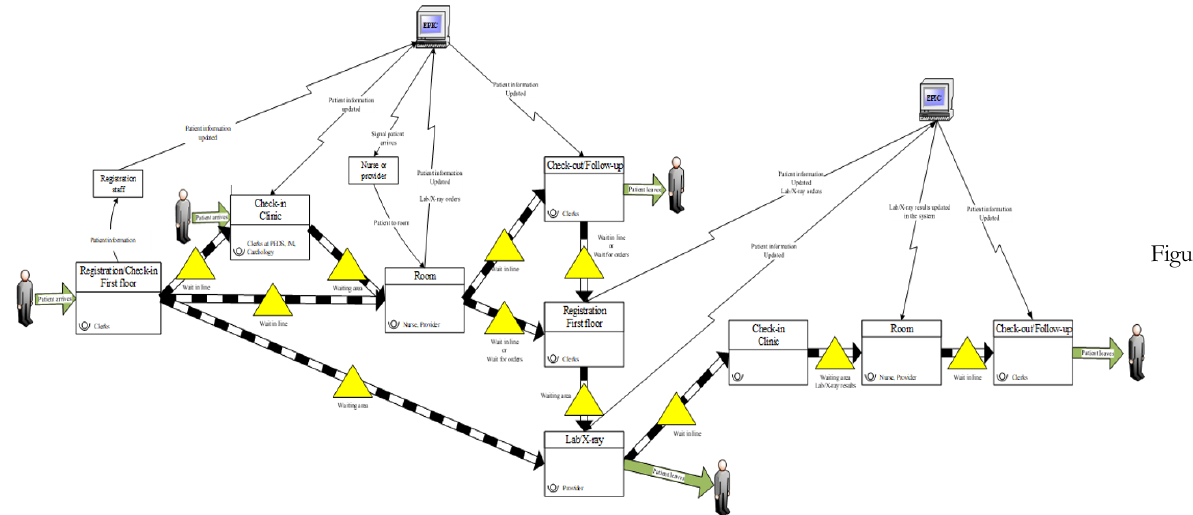
1. VSM of registration and check-in processes (Current